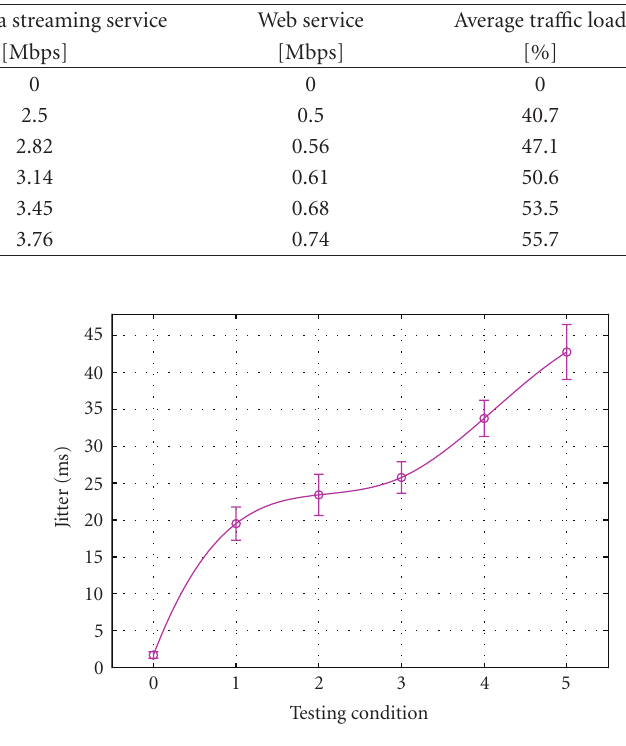
Figure 8: Impact of background tra ffi c on average value of jitter in VoWLAN connections. Other detailed descriptions of Figure 7 apply